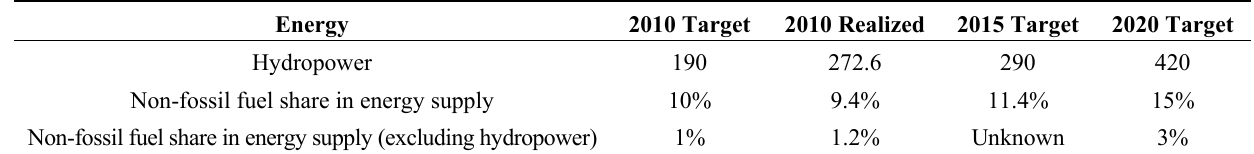
Table 1. Key energy targets enacted in China’s 12th FYP (2011–2015).